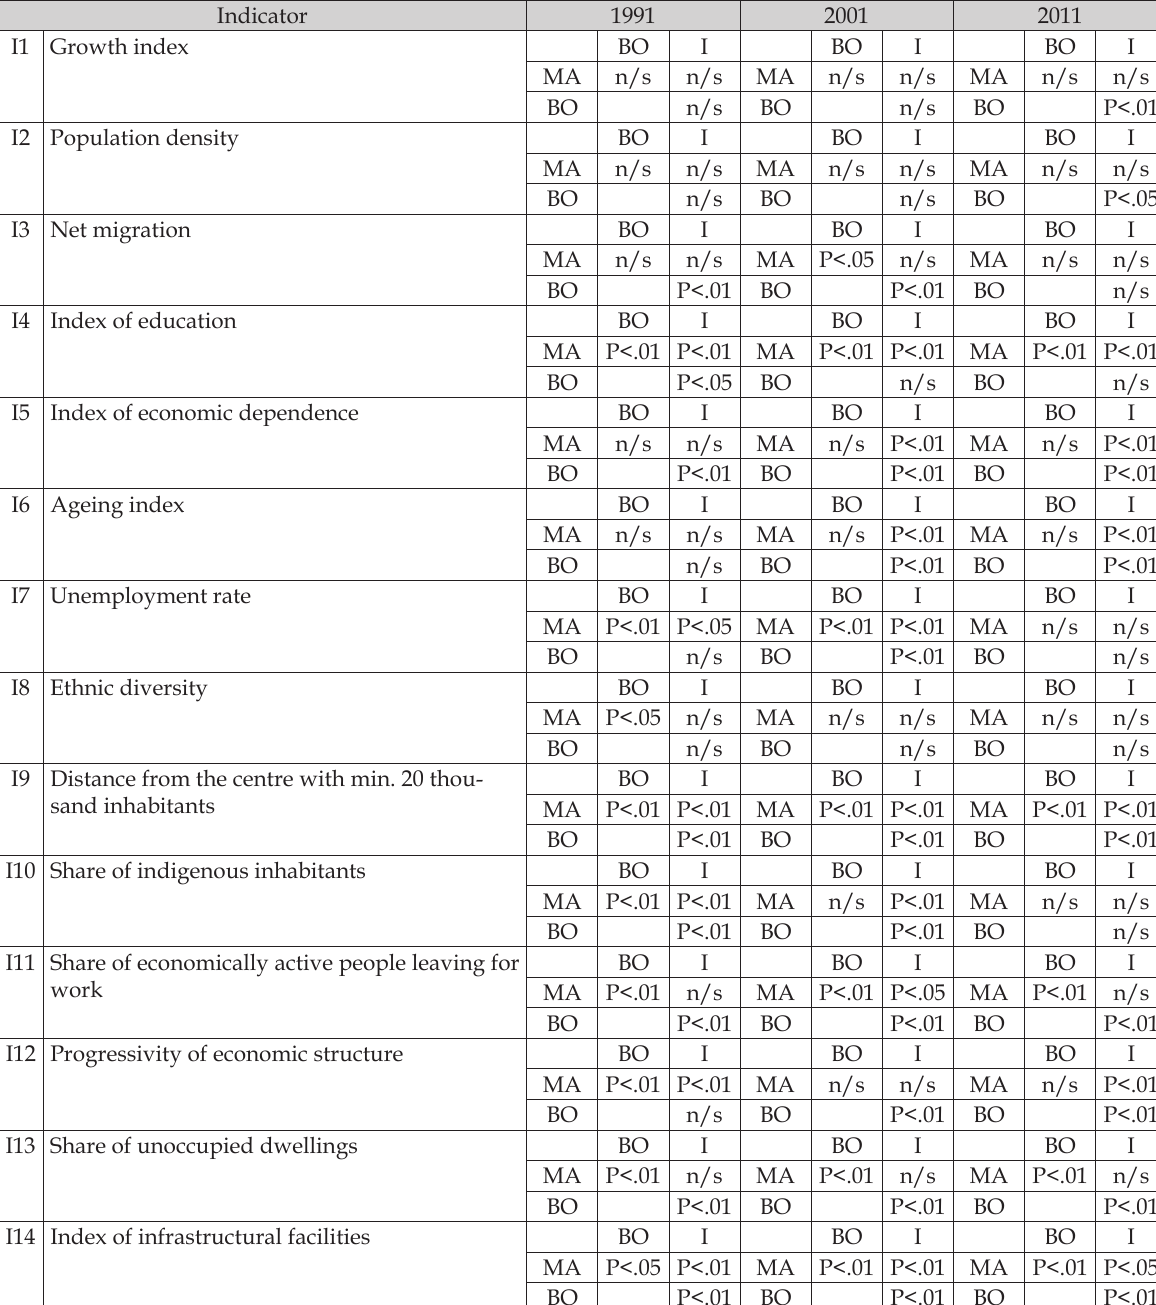
Table 2. Tukey’s HSD test for post-ANOVA pair-wise comparisons in a one-way ANOVA.